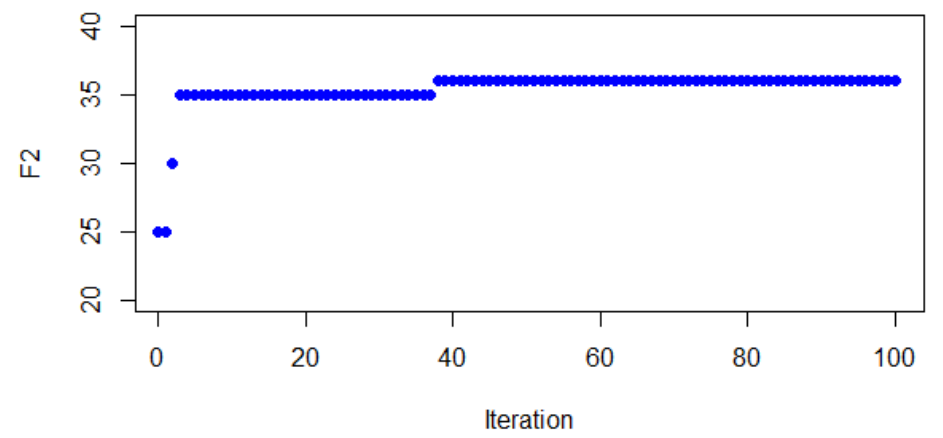
Figure 3. Illustrating the convergence of BONXEA regarding F 2